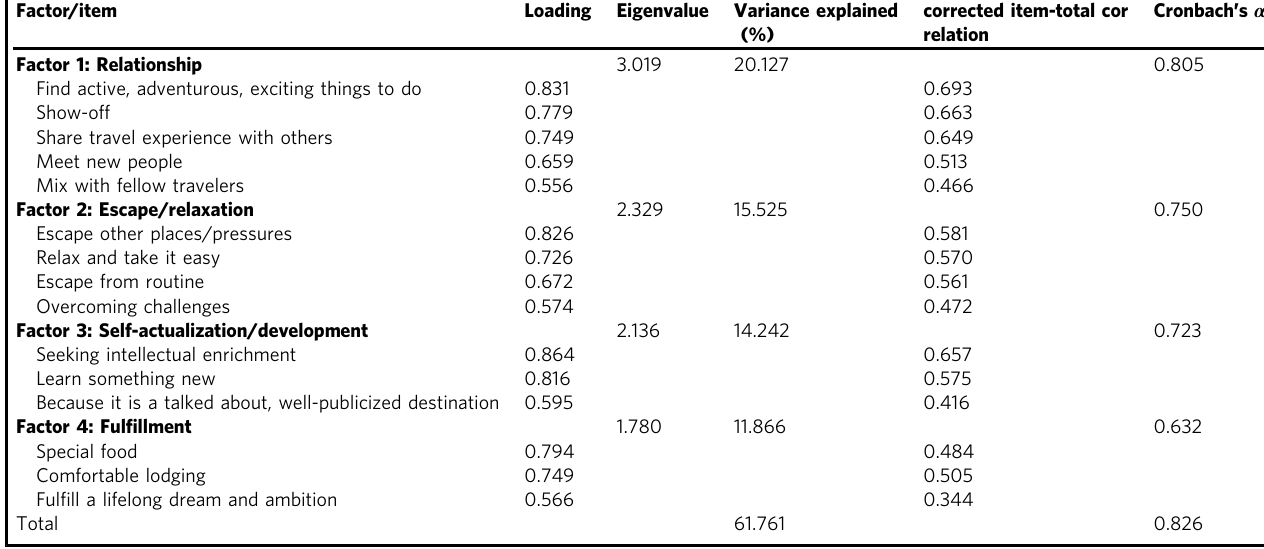
Table 4 EFA of female solo travel